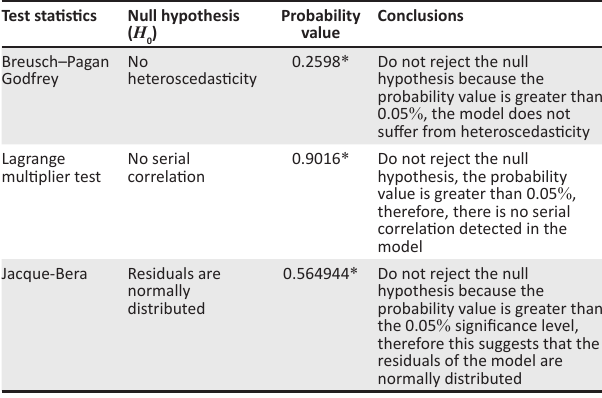
relationships between labour absorption, age15_34, age35_54, Female work-seekers, male work-seekers, GFCF and business